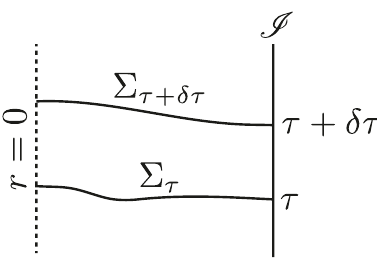
Figure 2 . Illustration of two static anchored maximal volume slices separated by boundary static time δτ . (1.5) provides a speed limit on the growth of dvol[Σ τ ]